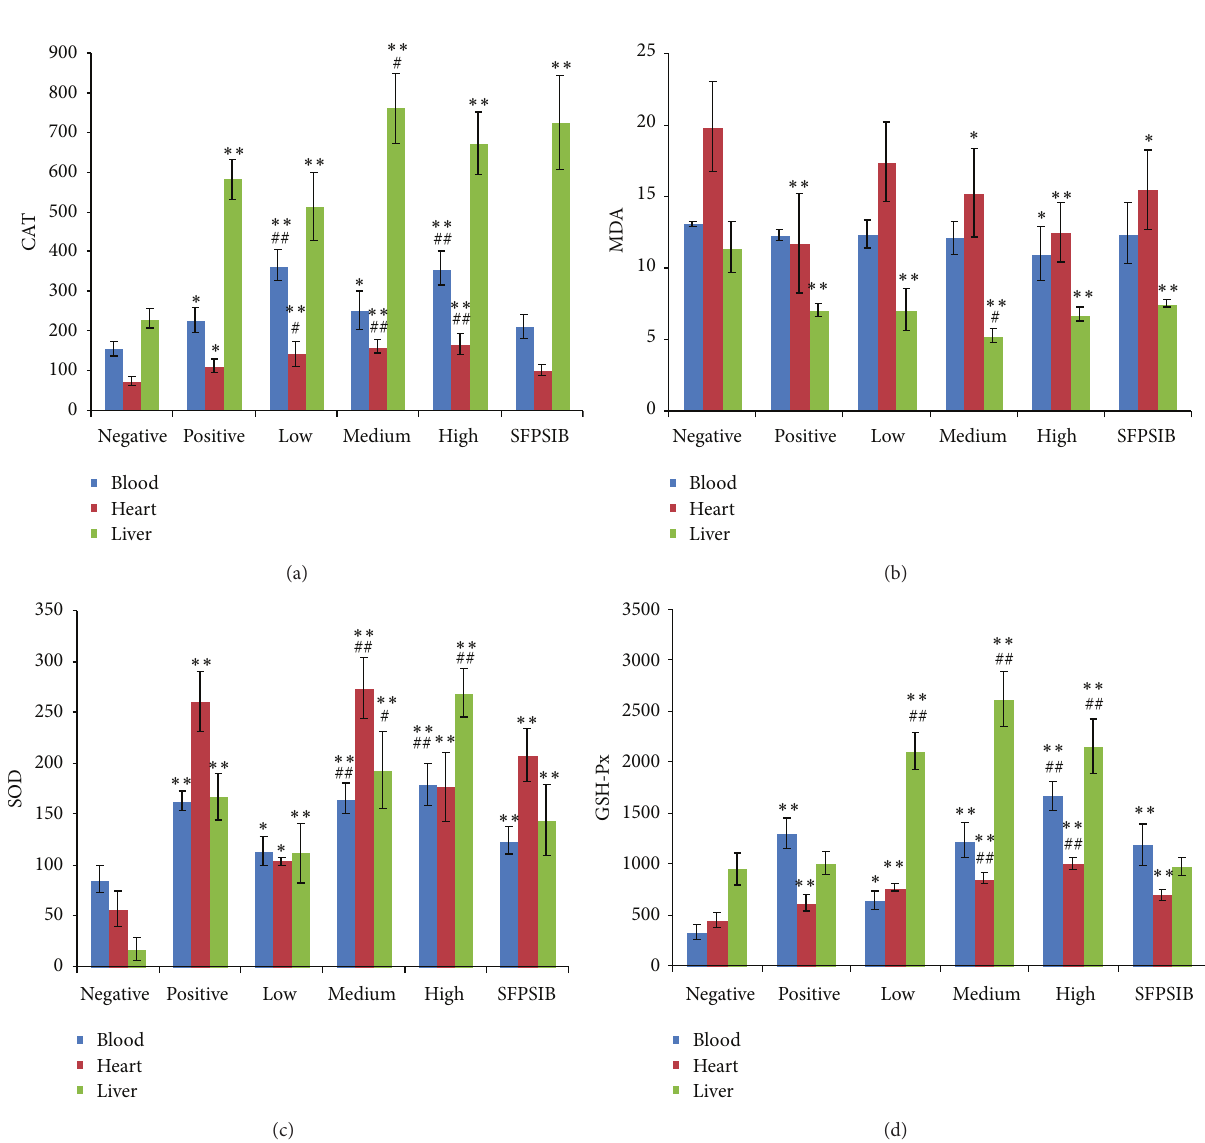
SOD is an important active enzyme to scavenge